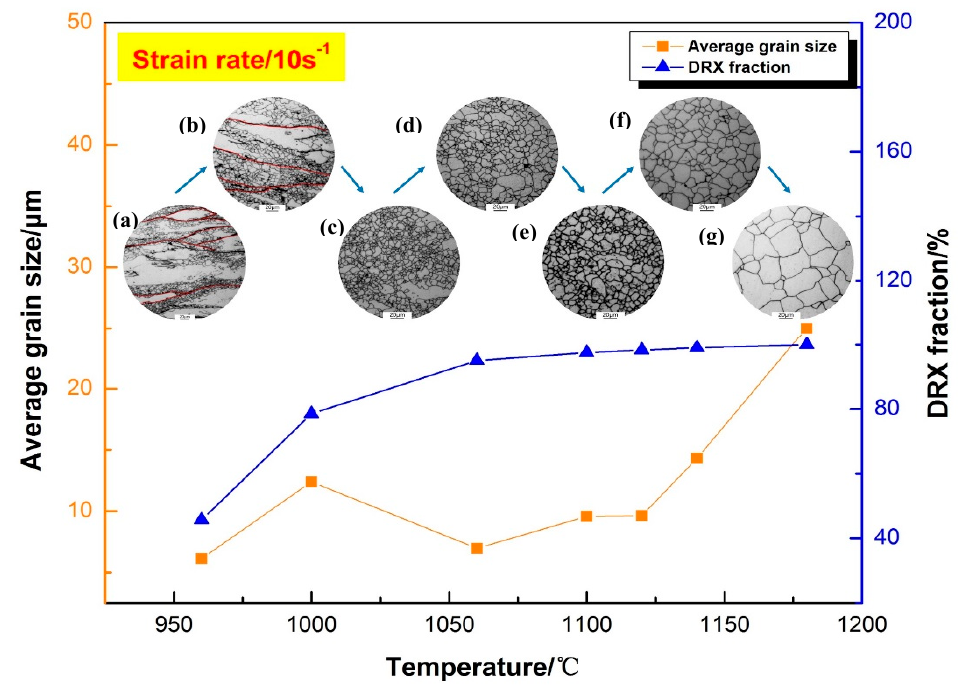
Figure 8. Schematic diagram of grain size, DRX fraction and optical microstructure of the specimens deformed at the strain rate of 10 s − 1 : ( a ) 960 °C, ( b ) 1000 °C, ( c ) 1060 °C, ( d ) 1100 °C, ( e ) 1120 °C, ( f ) 1140 °C, ( g ) 1180 °C.